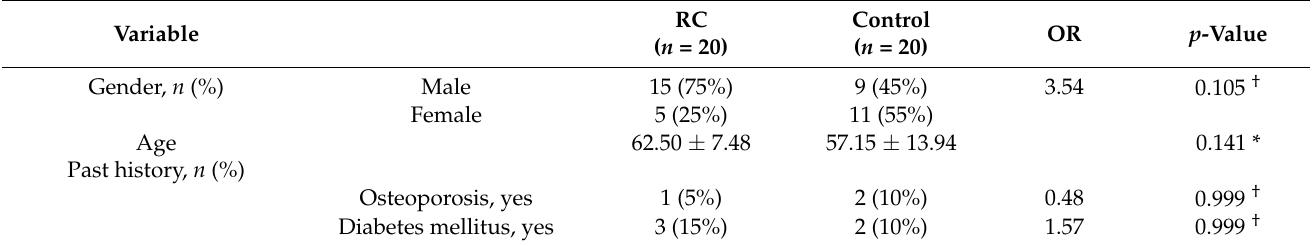
Table 1. Demographic and laboratory characteristics of the study